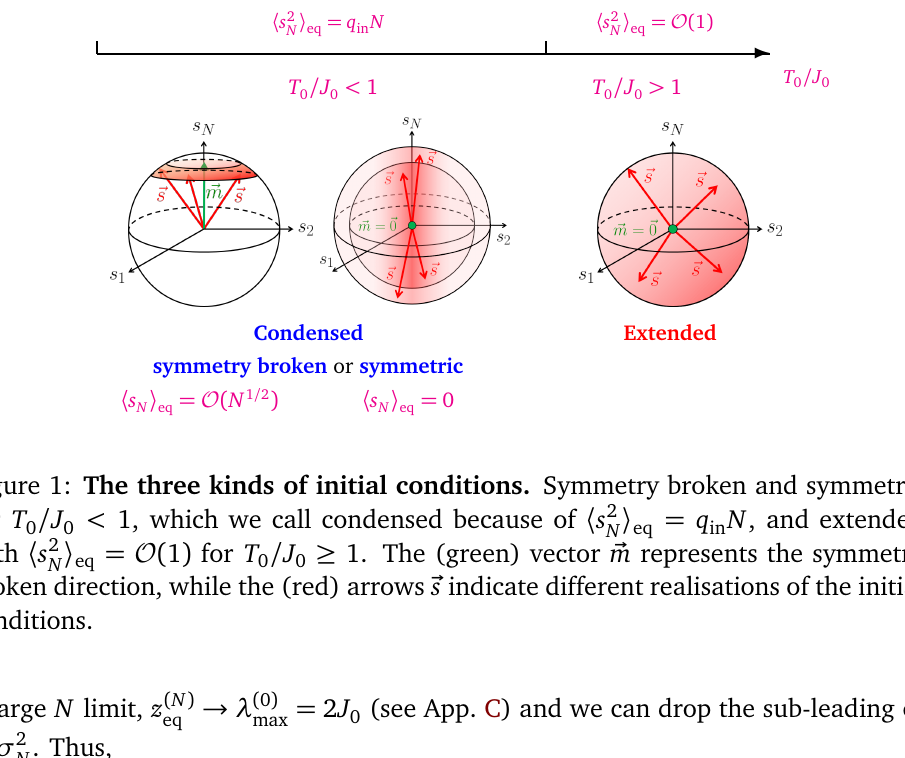
〉 = q N , and extended eq in N